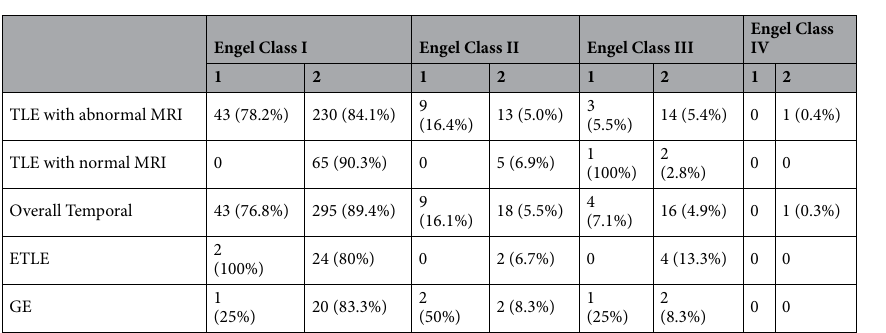
Table 5. Engel class outcome (comparison between the 1st and 2nd periods). 1 1st period, 2 2nd period, TLE Temporal lobe epilepsy, MRI Magnetic resonance imaging, ETLE Extratemporal lobe epilepsy, GE Generalized